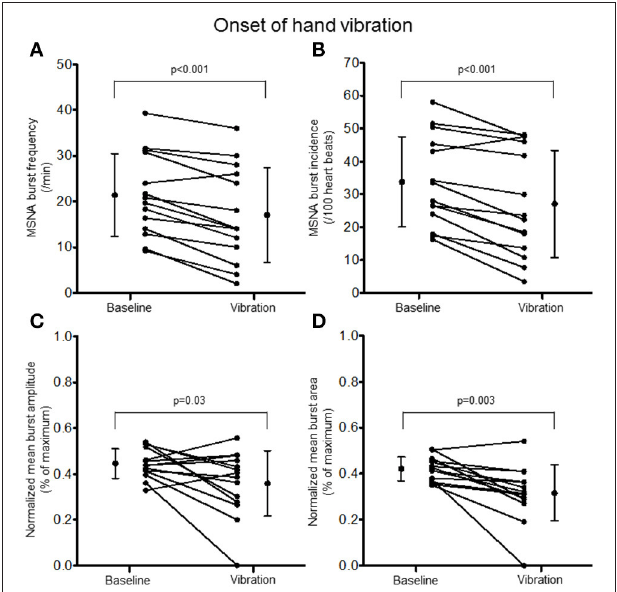
FIGURE 6 | Muscle sympathetic nerve activity (MSNA) burst frequency (A) , burst incidence (B) , and normalized mean burst amplitude (C) and area (D) during 2 min of baseline rest and the onset (10 s) of foot sole vibration.